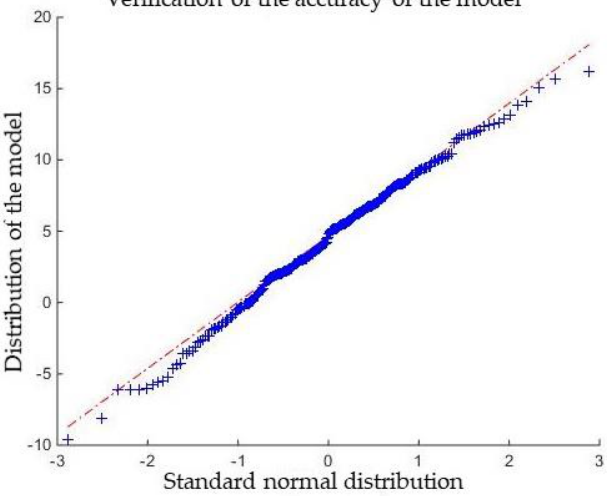
Figure 15. The Quantile-Quantile plot of model and standard normal distribution